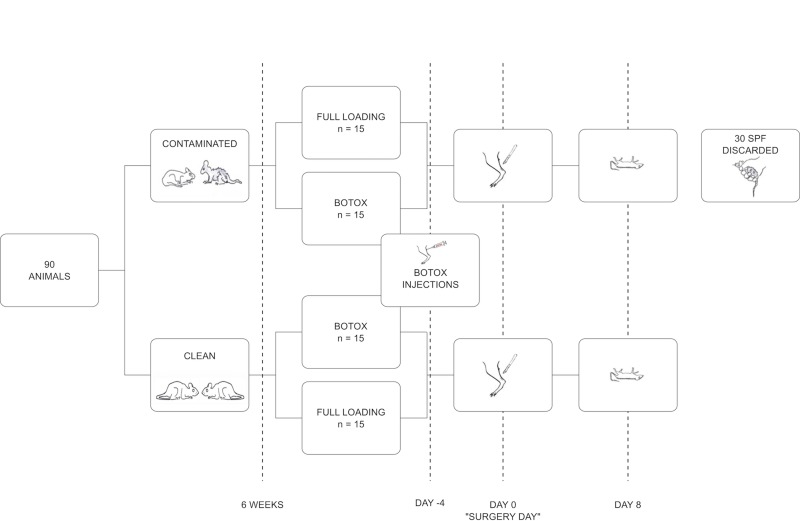
Experimental set-up.